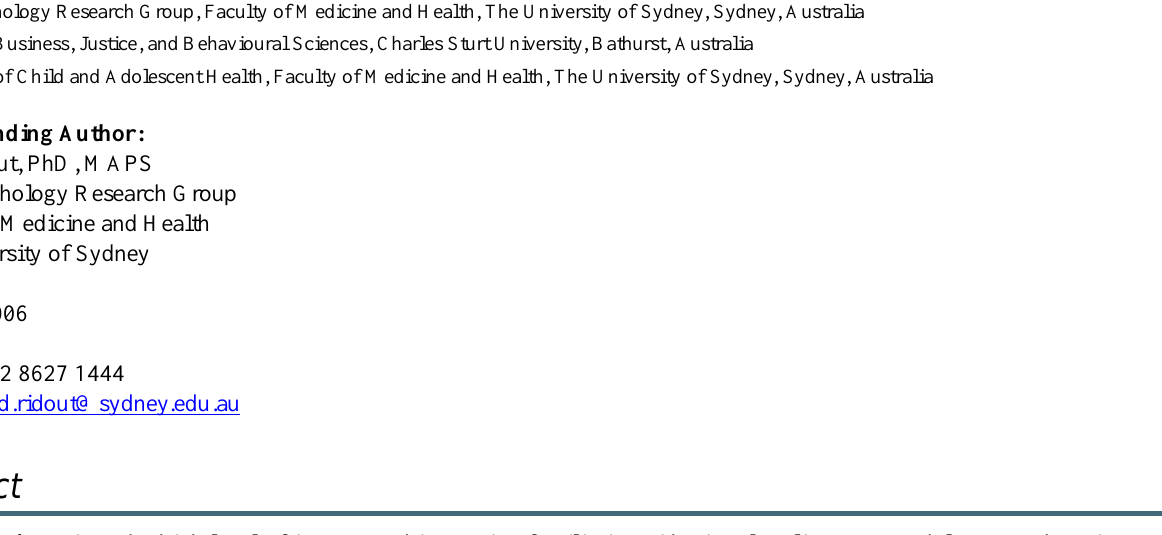
virtual reality; hospital; pain; anxiety;